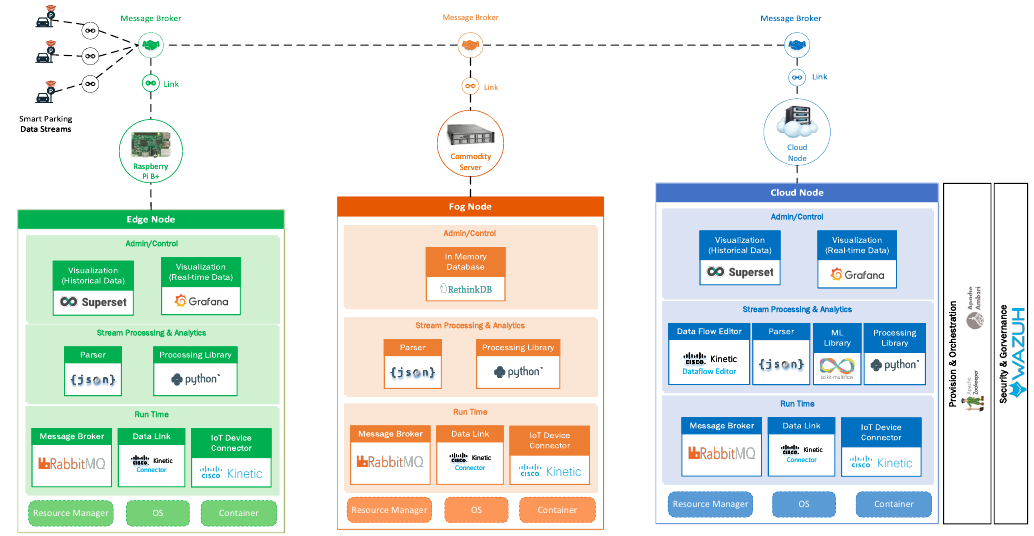
Figure 4. Implementation of the architecture for the smart parking application.